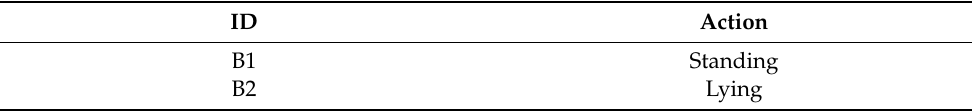
Table 5. Standing/lying behaviour annotations.